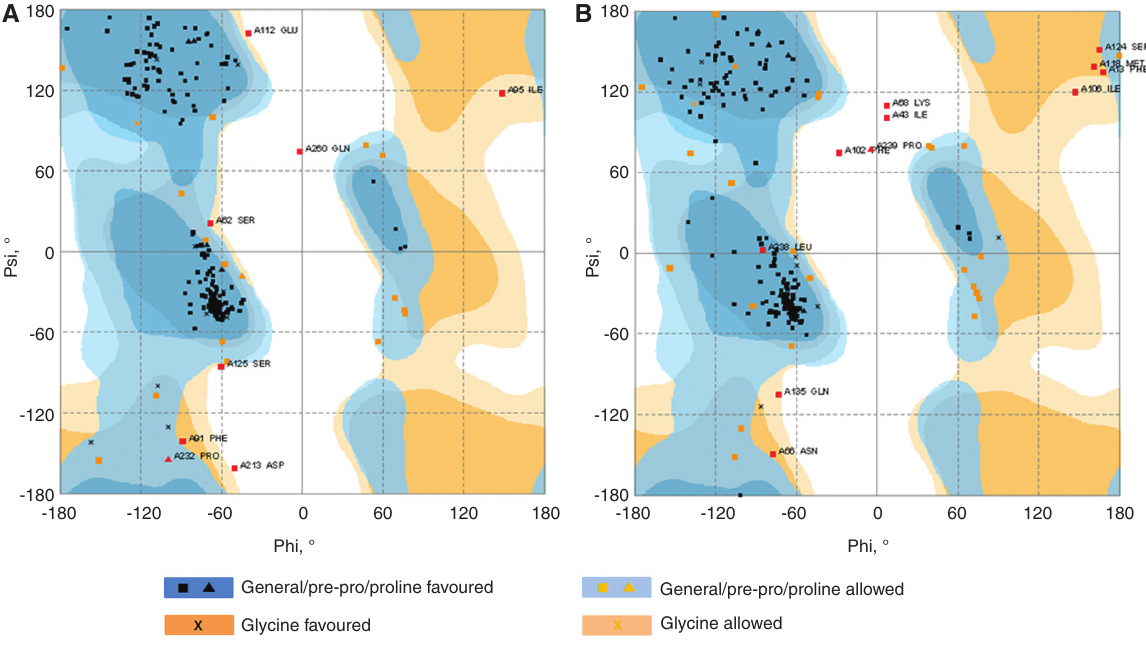
Figure 2: Homology model validation using the RAMPAGE server. (A) Ramachandran plot for Model 1 of CG12117. (B) Ramachandran plot for Model 1 of CG12116. RAMPAGE analyses showed that 90.3% and 86.7% of the residues are located in the favorable region and that 6.6% and 9.2% of the residues are present in the allowed region, respectively. The analyses also showed that 3.1% and 4.1% of the residues are located in the disallowed region of the Ramachandran plots of the models for CG12117 and CG12116, respectively.